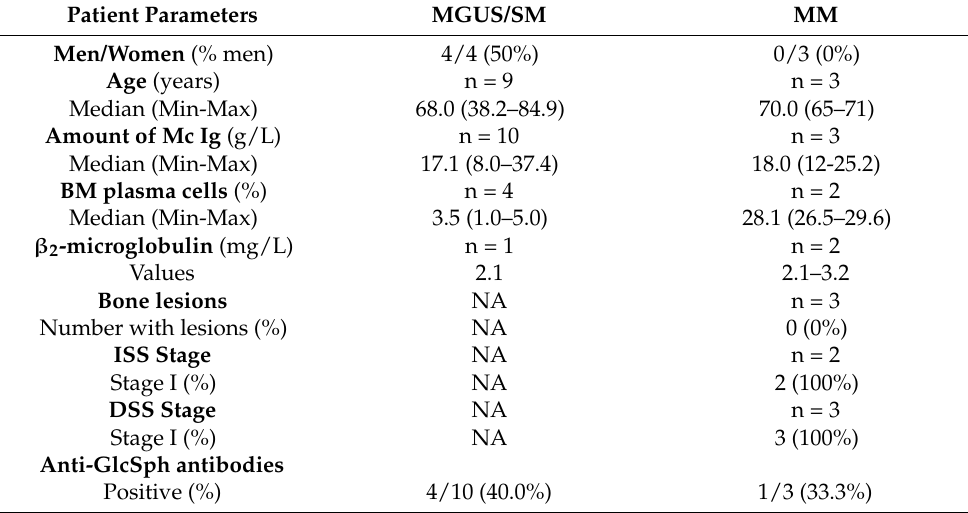
Table 2. Characteristics of Patients with a PALTAV/AETG-Specific Monoclonal